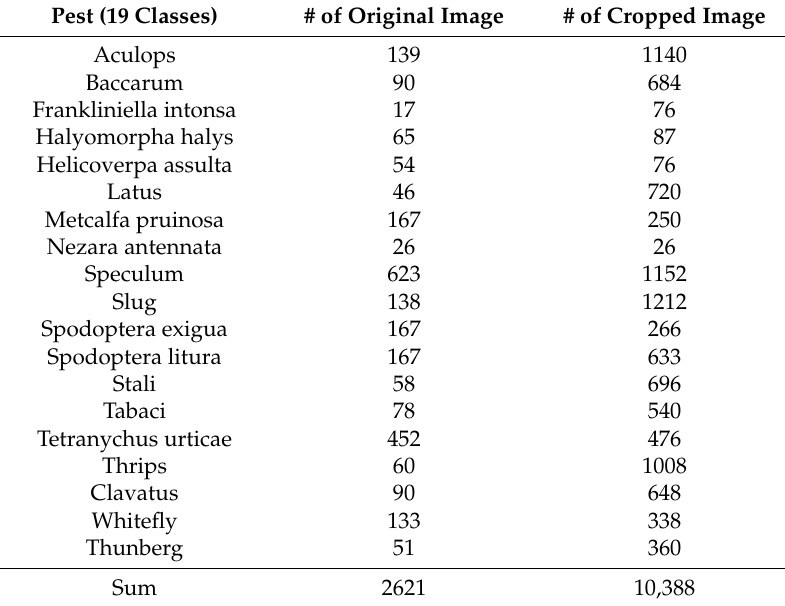
Table 2. Summary of hot pepper pest